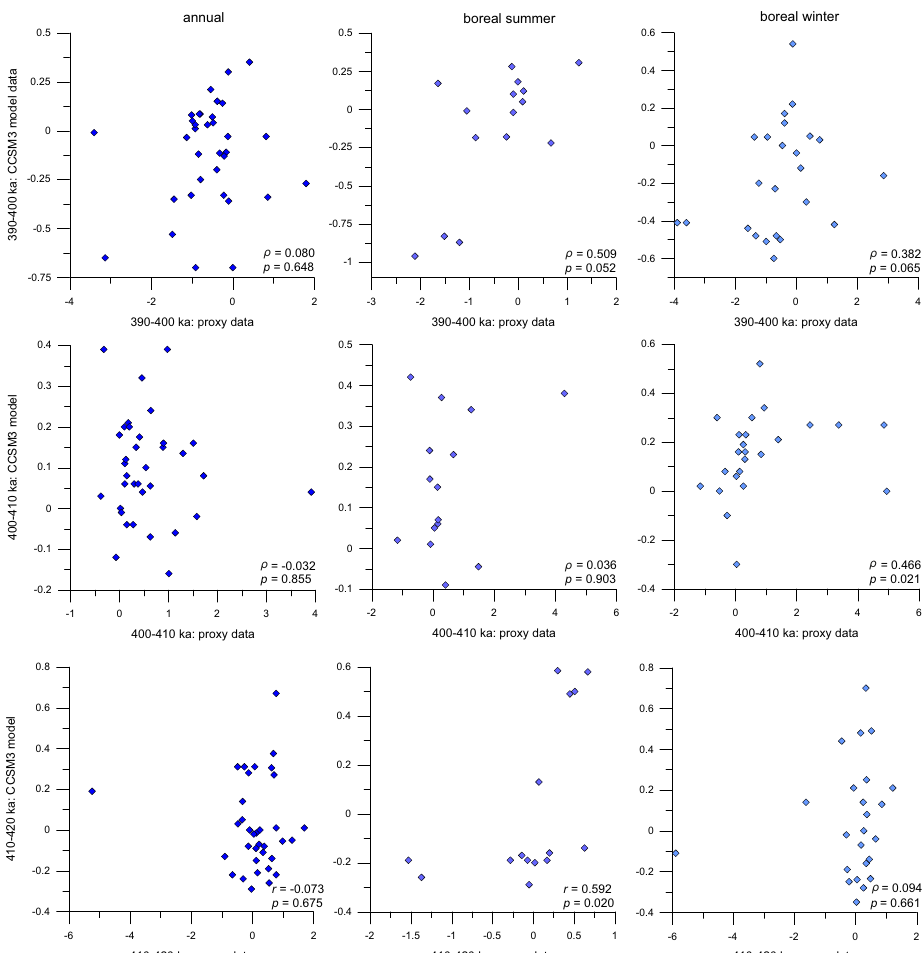
Fig. 7. Correlations between the proxy SST anomalies (annual, boreal summer and boreal winter) (in kelvin) and the model SST anomalies (in kelvin) for 390–400, 400–410 and 410–420ka time slices. Given are the Pearson ( r ) and Spearman ( ρ ) correlations and p values (Table 4). Higher positive correlations between the proxy and model data can be observed for the boreal summer seasons of the 390–400 and 410–420ka time slices and for the boreal winter season of the 400–410ka time slice. Note different x and y axes scaling.